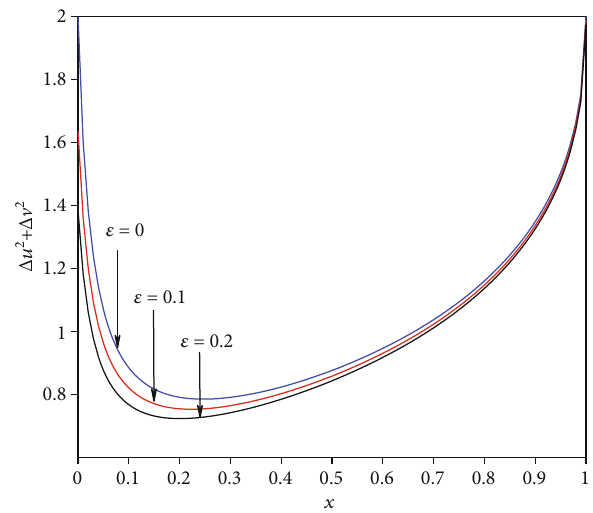
Figure 6: Duan et al. criterion Δ u 2 + Δ v 2 versus x for κ = 0 : 5 , A = 50 , and di ff erent values of ε .